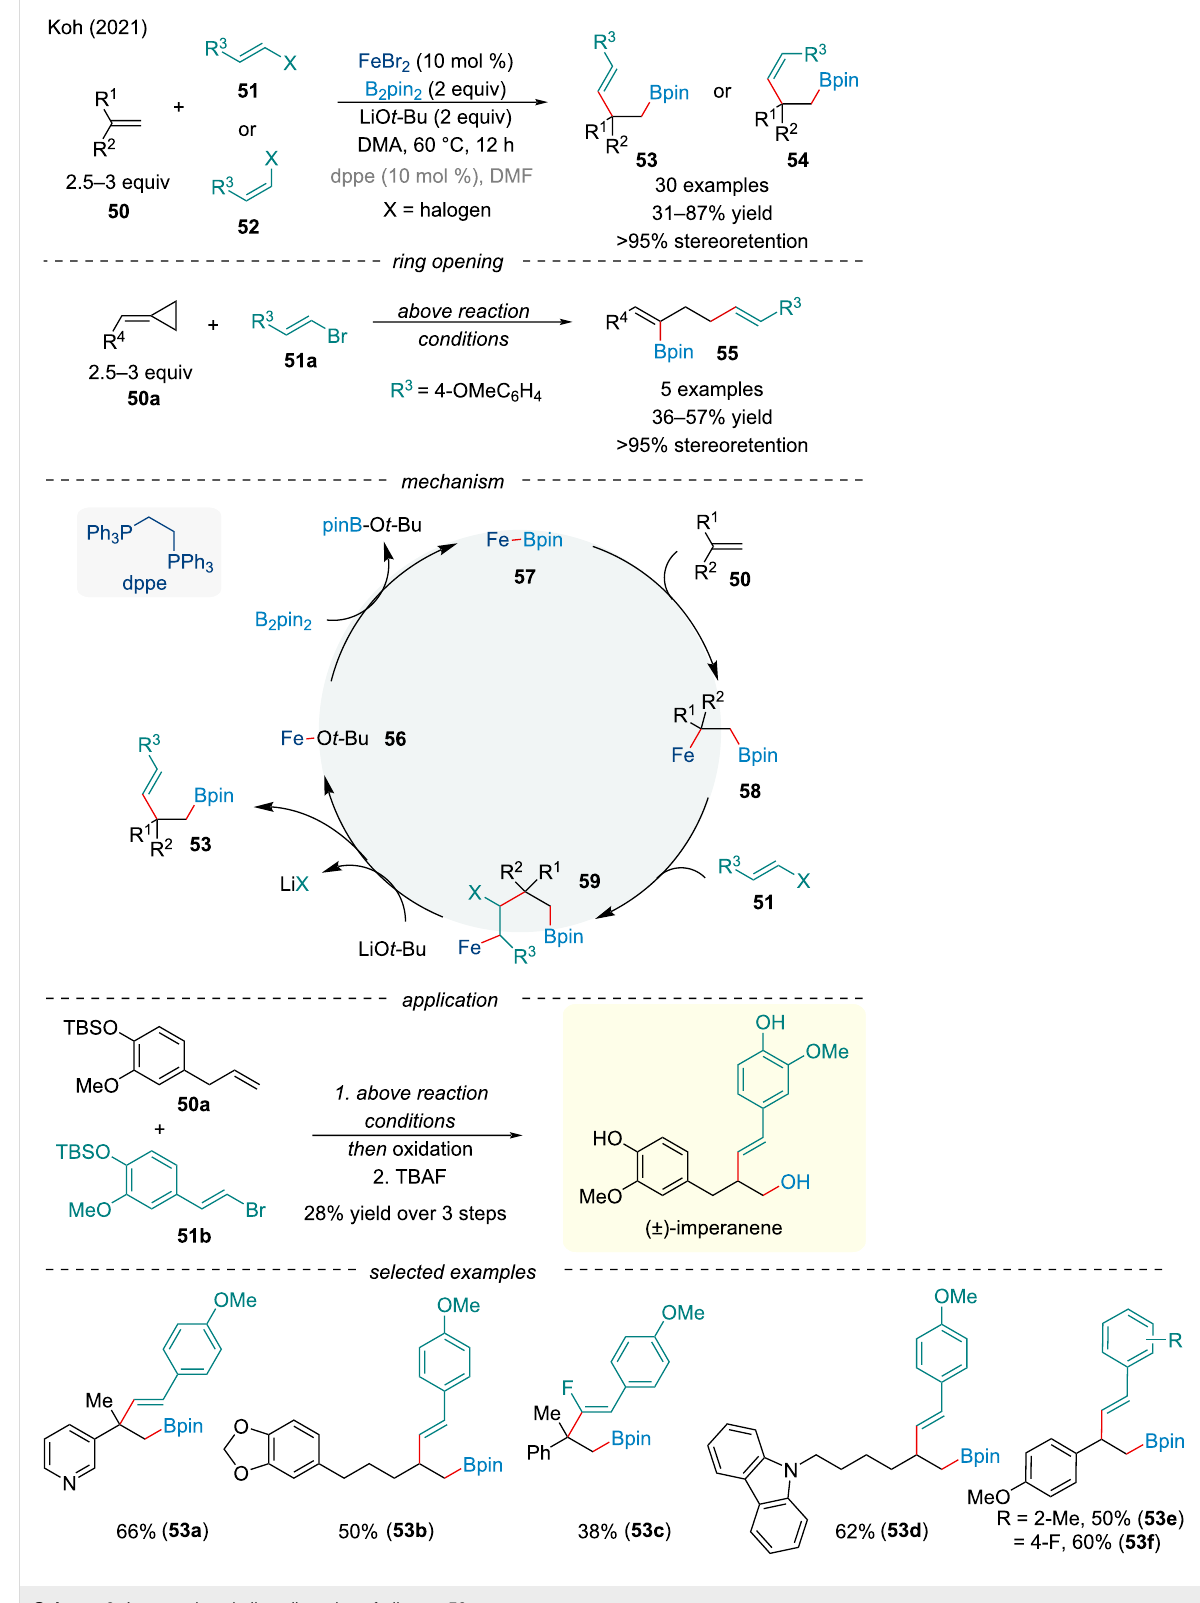
Scheme 9: Iron-catalyzed alkenylboration of alkenes 50